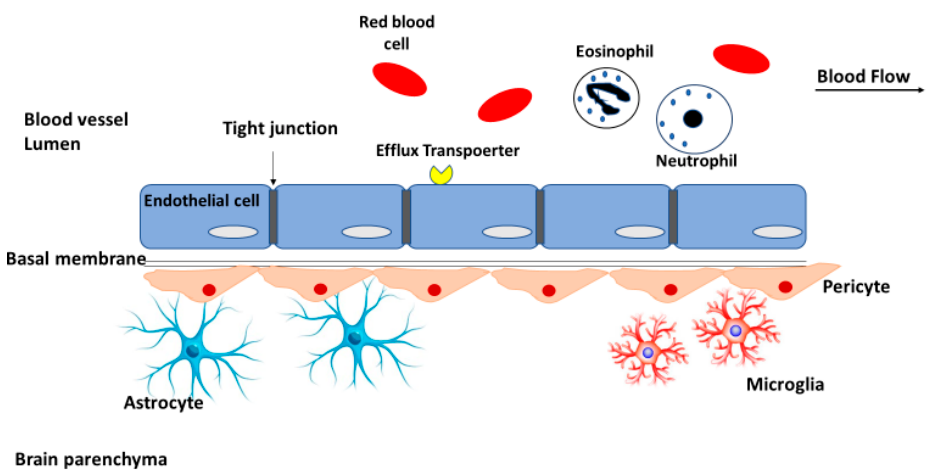
Figure 2. A schematic diagram of the structure of the blood-brain barrier (BBB), the main obstacle for drug penetration into the brain.